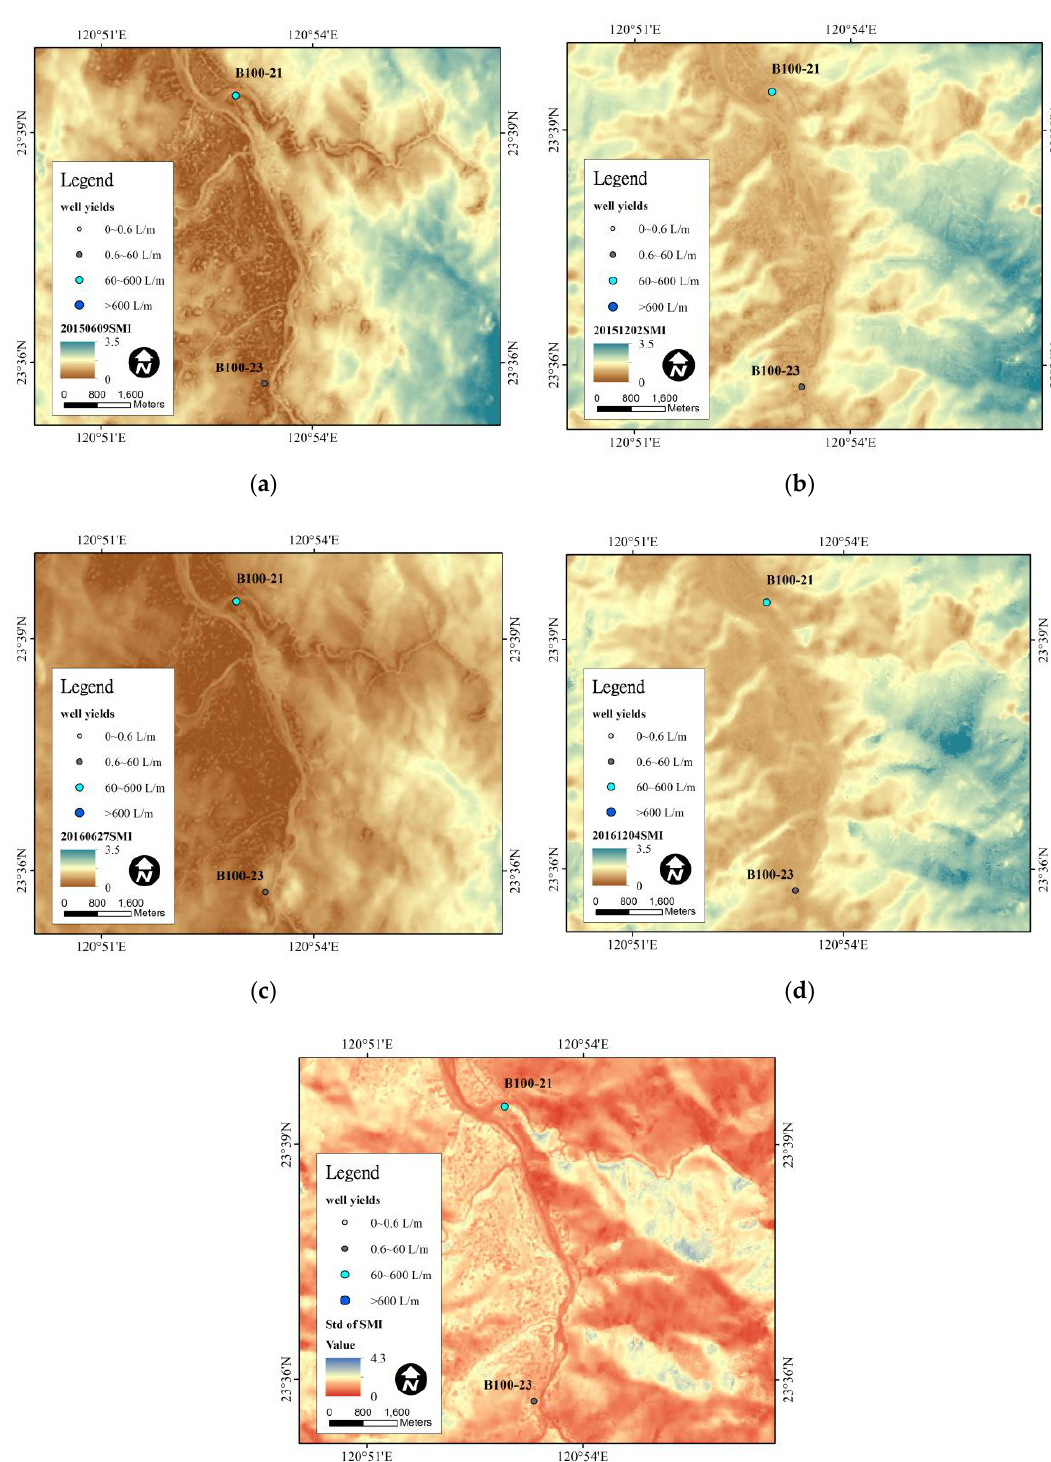
Figure 9. The dynamic fluctuation of SMI in wet and dry seasons, and its distribution of standard deviation. A case between B100-21 and B100-23 sites: ( a ) wet season on 9 June 2015; ( b ) dry season on 2 December 2015; ( c ) wet season on 27 June 2016; ( d ) dry season on 4 December 2016; ( e ) standard deviation of SMI.